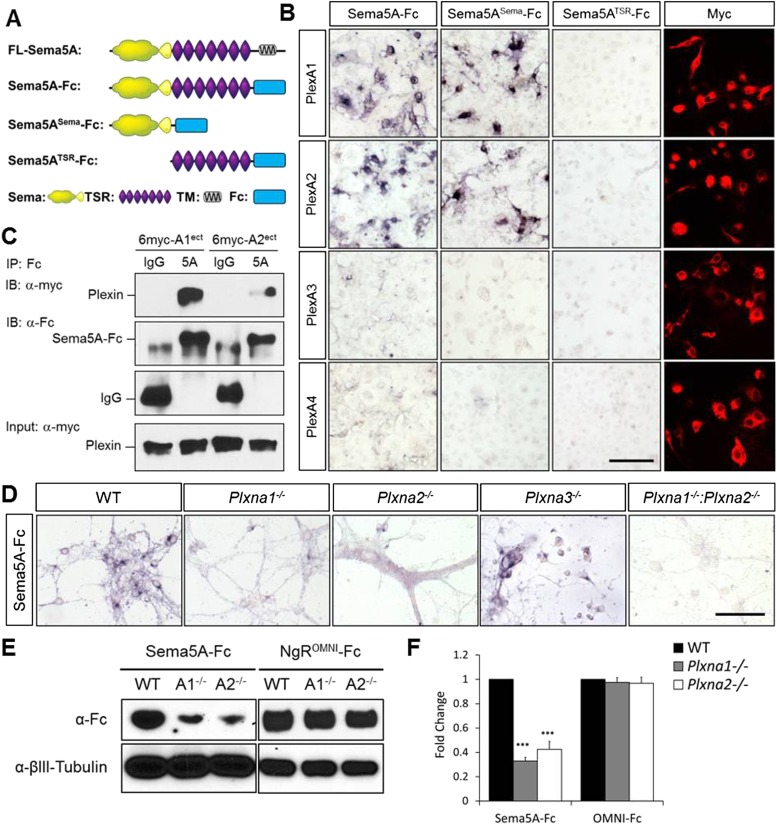
Direct binding of Sema5A to PlexA1 and PlexA2.(A) Schematic diagrams of Sema5A domain deletion constructs used for binding studies. (B) Binding of different Sema5A-Fc fusion proteins to COS7 cells transiently expressing myc-tagged PlexA1, PlexA2, PlexA3, or PlexA4. Sema5A-Fc and Sema5ASema-Fc bind selectively to PlexA1 and PlexA2. PlexA expression was confirmed by anti-myc immunostaining. (C) Co-precipitation of purified ectodomain of Sema5A (Sema5A-Fc) with the ectodomains of PlexA1 (6x-myc-PlexA1ect) or PlexA2 (6x-myc-PlexA2ect). Immunoprecipitation (IP) with anti-Fc shows that Sema5A-Fc (5A), but not control IgG, forms a complex with the ectodomains of PlexA1 and PlexA2. The precipitated plexin fragments can be detected by anti-myc immunoblotting (top blot). Immunoblotting with an antibody specific for the Fc fragment detects Sema5A-Fc and control IgG in the precipitate (second blot from top). Note that the higher molecular weight band is Sema5A-Fc and the lower molecular weight band is intact (not fully reduced ∼150-kDa) IgG. Anti-IgG immunoblotting shows that control IgG at 50-kDa was successfully pulled down with protein A/G agarose-beads (third blot from top). To demonstrate that equal amounts of plexinA ectodomain were used for the IP experiment, an aliquot of the input was probed with anti-myc (blot at bottom). (D) Binding of Sema5A-Fc to primary hippocampal neurons established from WT, Plxna1, Plxna2 and Plxna3 single null mice as well as Plxna1; Plxna2 double null mice. (E) Hippocampal neurons from WT, Plxna1−/−, and Plxna2−/− mice were incubated with either Sema5A-Fc (50 nM) or NgROMNI-Fc (50 nM) for 1 hr. Cells were rinsed extensively, lysed, and subjected to WB analysis. Sema5A-Fc binding to Plxna1−/− and Plxna2−/− neurons is reduced compared to WT neurons. NgROMNI-Fc binding was strong to hippocampal neurons and independent of the Plxna genotype. Anti-βIII tubulin in lysates is shown as a loading control. (F) Quantification of Western blot signals from three independent experiments. Scale bars in B and D = 50 µm.